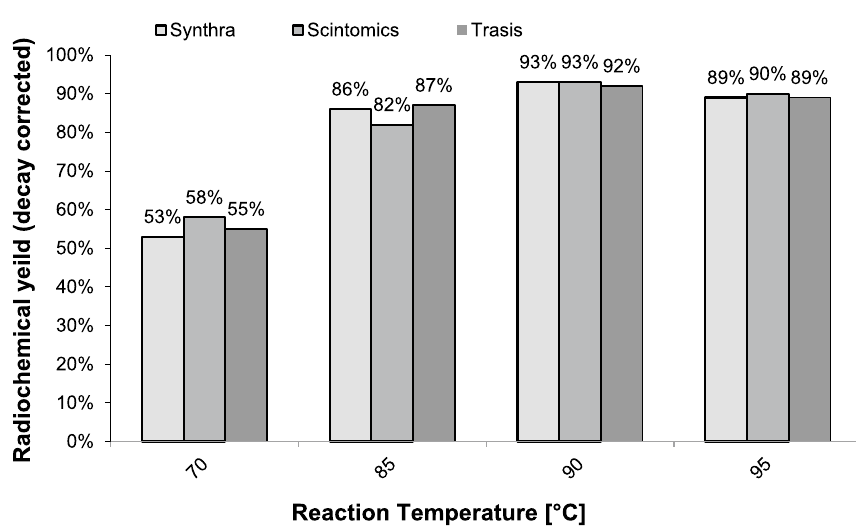
Fig. 8 Radio chemical yield of [ 68 Ga]Ga-FAPI-46 (n 4-min reaction time and in buffered medium containing 300 µg ascorbic